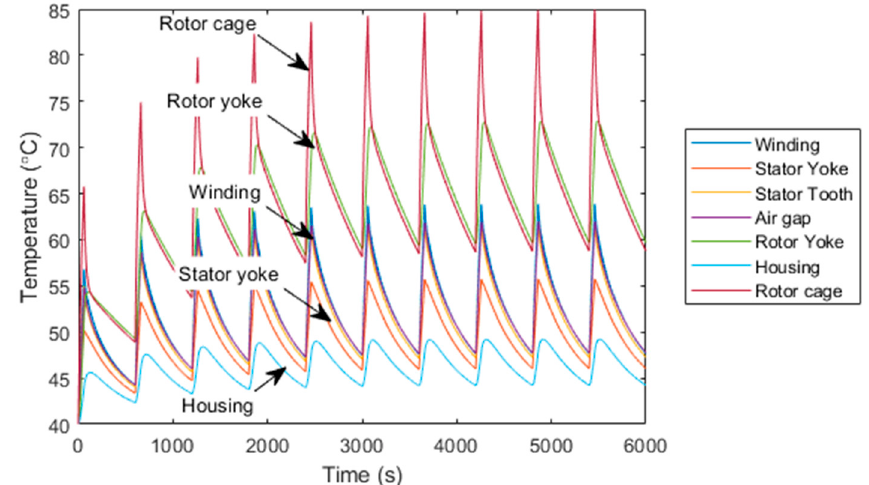
Figure 7. Thermal simulation for S3 10% duty cycle.